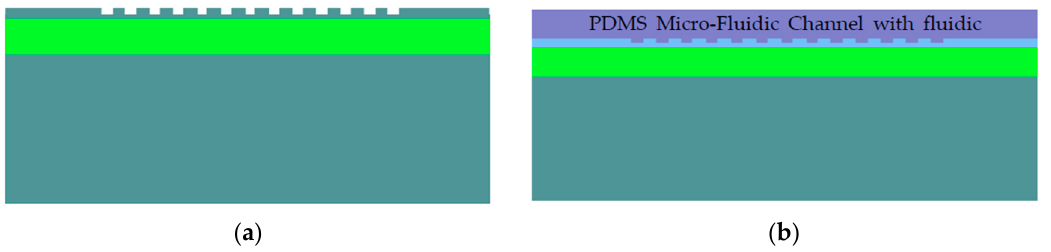
Figure 2. Grating structure dimensions.